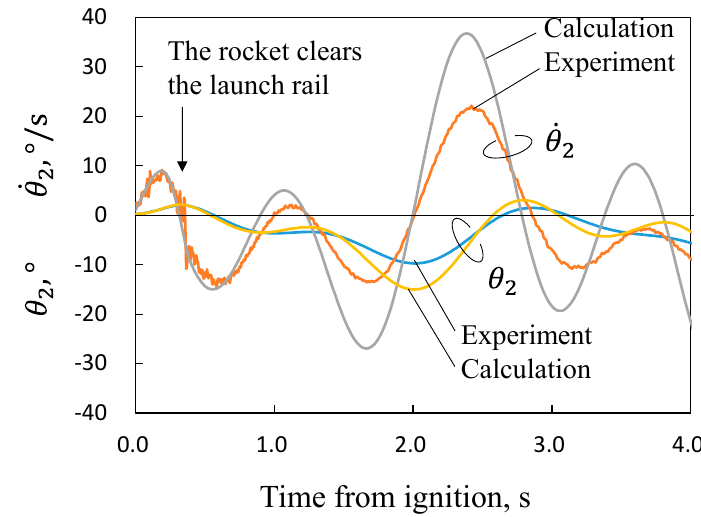
Figure 9. Double pendulum model of the suspended launcher.